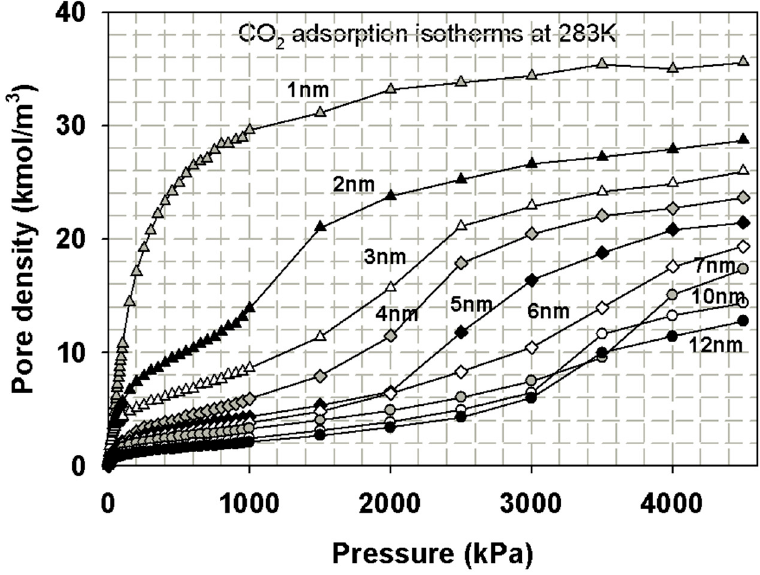
Figure 11. Adsorption isotherms of CO 2 on finite-length slit pore model of porous silica glass at 283 K.